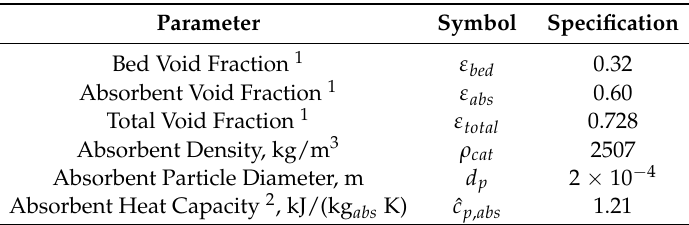
Table 4. Absorber